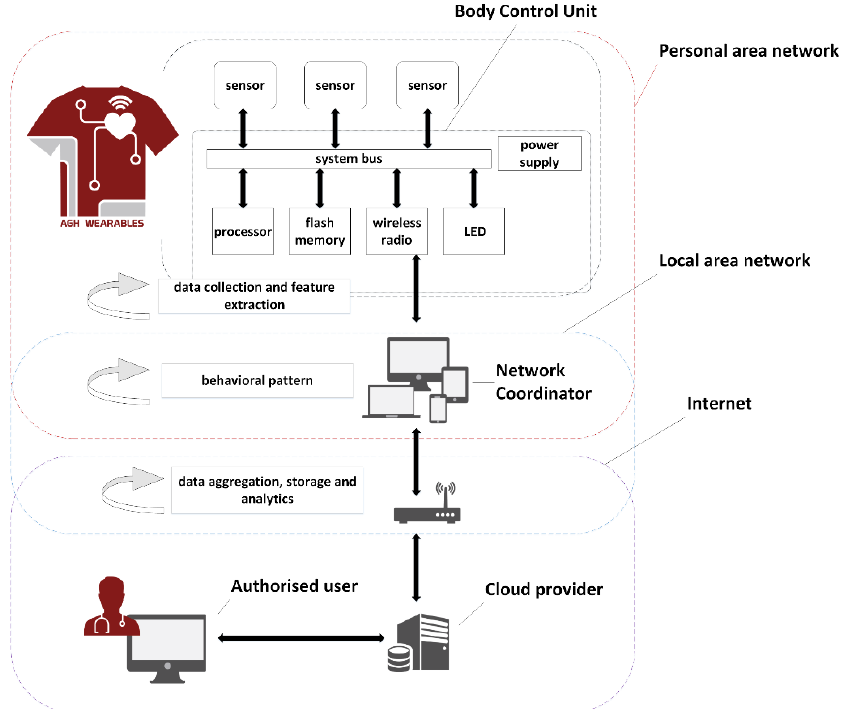
Figure 2. System architecture.